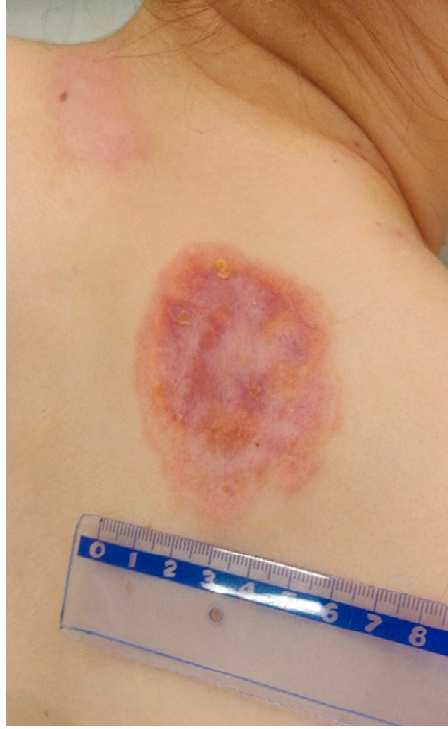
Figure 12. Lesions examined during the follow-up at the University Dermatological Outpatient Clinic (6 months after hospitalisation).